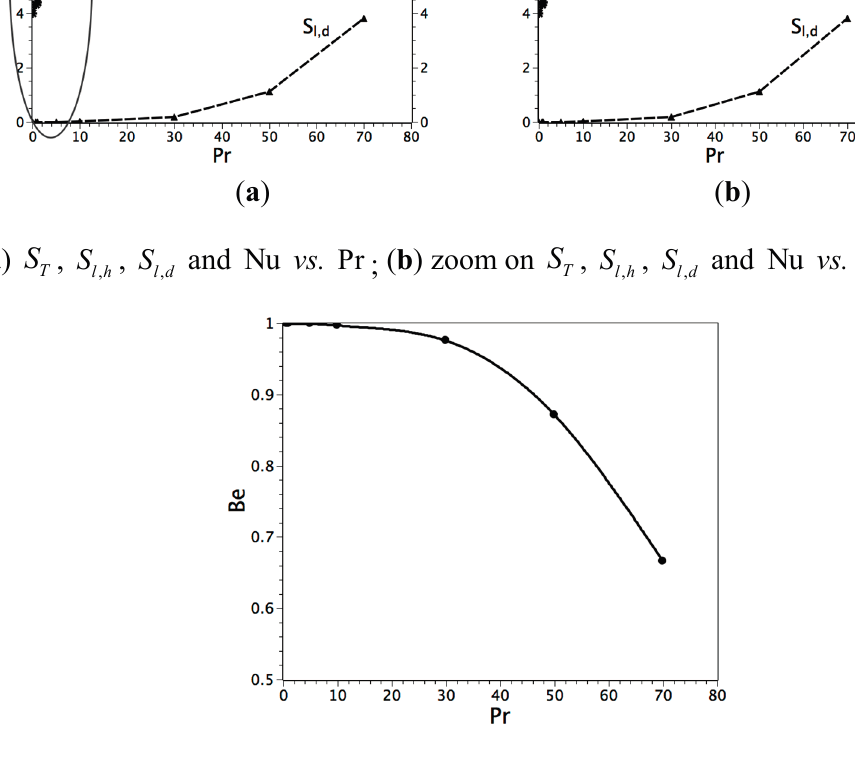
Figure 8. Bejan number vs. Prandtl number.